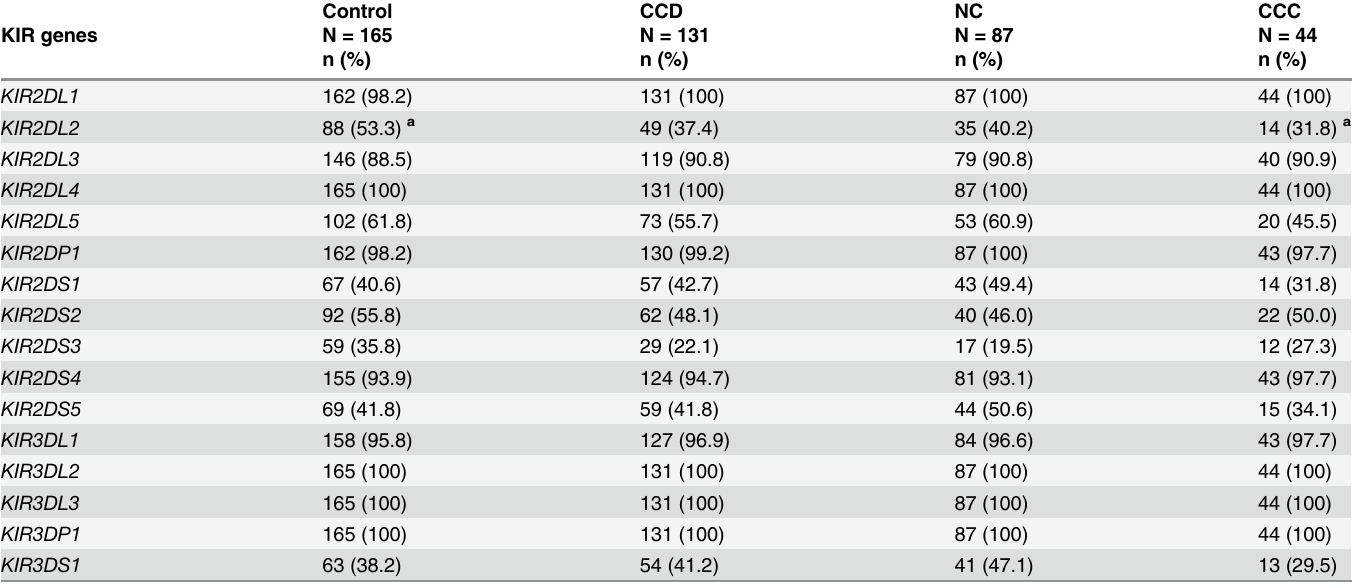
Table 2. Distribution of KIR genes in healthy controls, chronic Chagas disease patients and in groups of patients with and without heart involvement. Control CCD CCC KIR